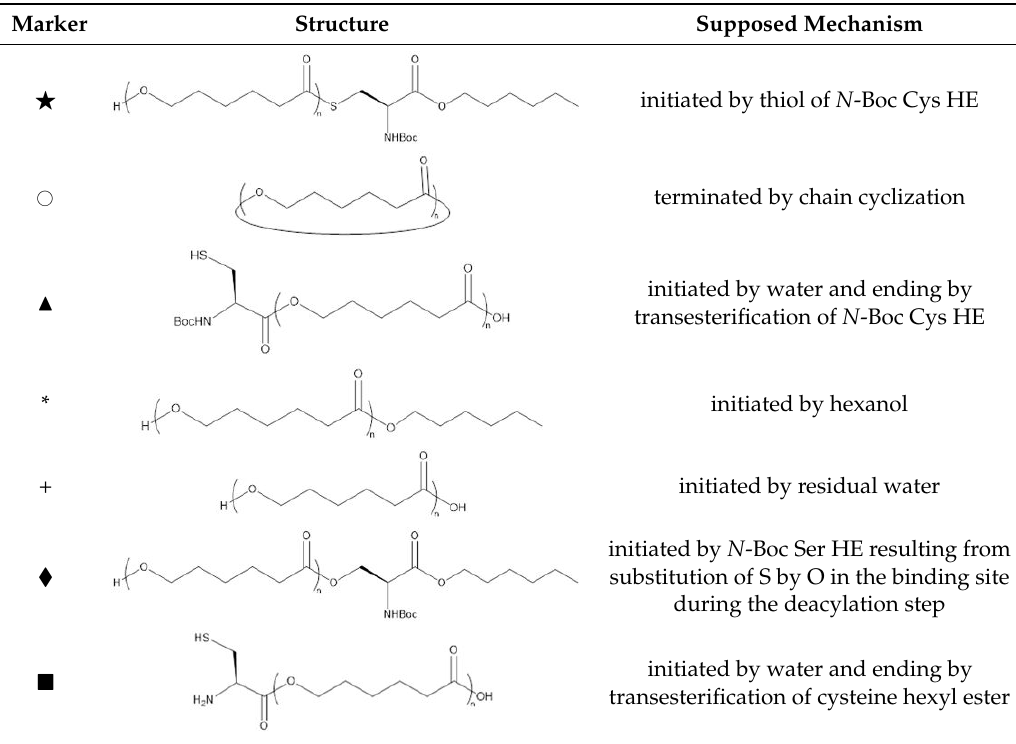
Table 3. Proposed structures and mechanisms for CL polymerization with N -Boc Cys